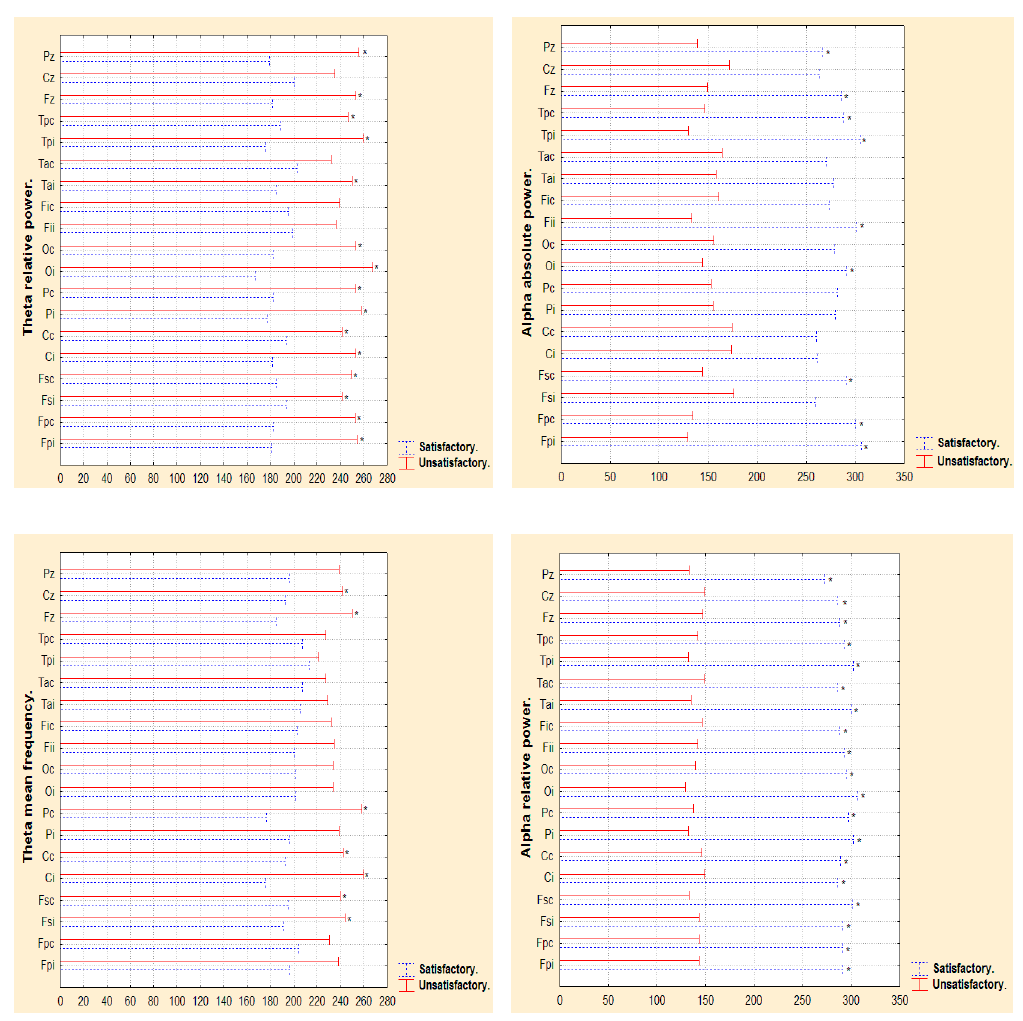
Figure 2. Mann Whitney. Differences in theta relative power and theta mean frequency, and alpha absolute power and alpha relative power, between patients with satisfactory and unsatisfactory post-surgical evolution in the second year after surgery. Fpc, Fsc, Cc, Pc, Oc, Fic, Tac, Tpc (Front-polar Contralateral, frontal superior Contralateral, central Contralateral, parietal Contralateral, occipital Contralateral, frontal inferior Contralateral, temporal anterior Contralateral, temporal posterior Contralateral electrodes), Fpi, Fsi, Ci, Pi, Oi, Fii, Tai, Tpi (Front-polar Ipsilateral, frontal superior Ipsilateral, central Ipsilateral, parietal Ipsilateral, occipital Ipsilateral, frontal inferior Ipsilateral, temporal anterior Ipsilateral, temporal posterior Ipsilateral electrodes), Fz, Cz, Pz (mid-line frontal, mid-line central, mid-line parietal). * (Electrodes with p < 0.05).